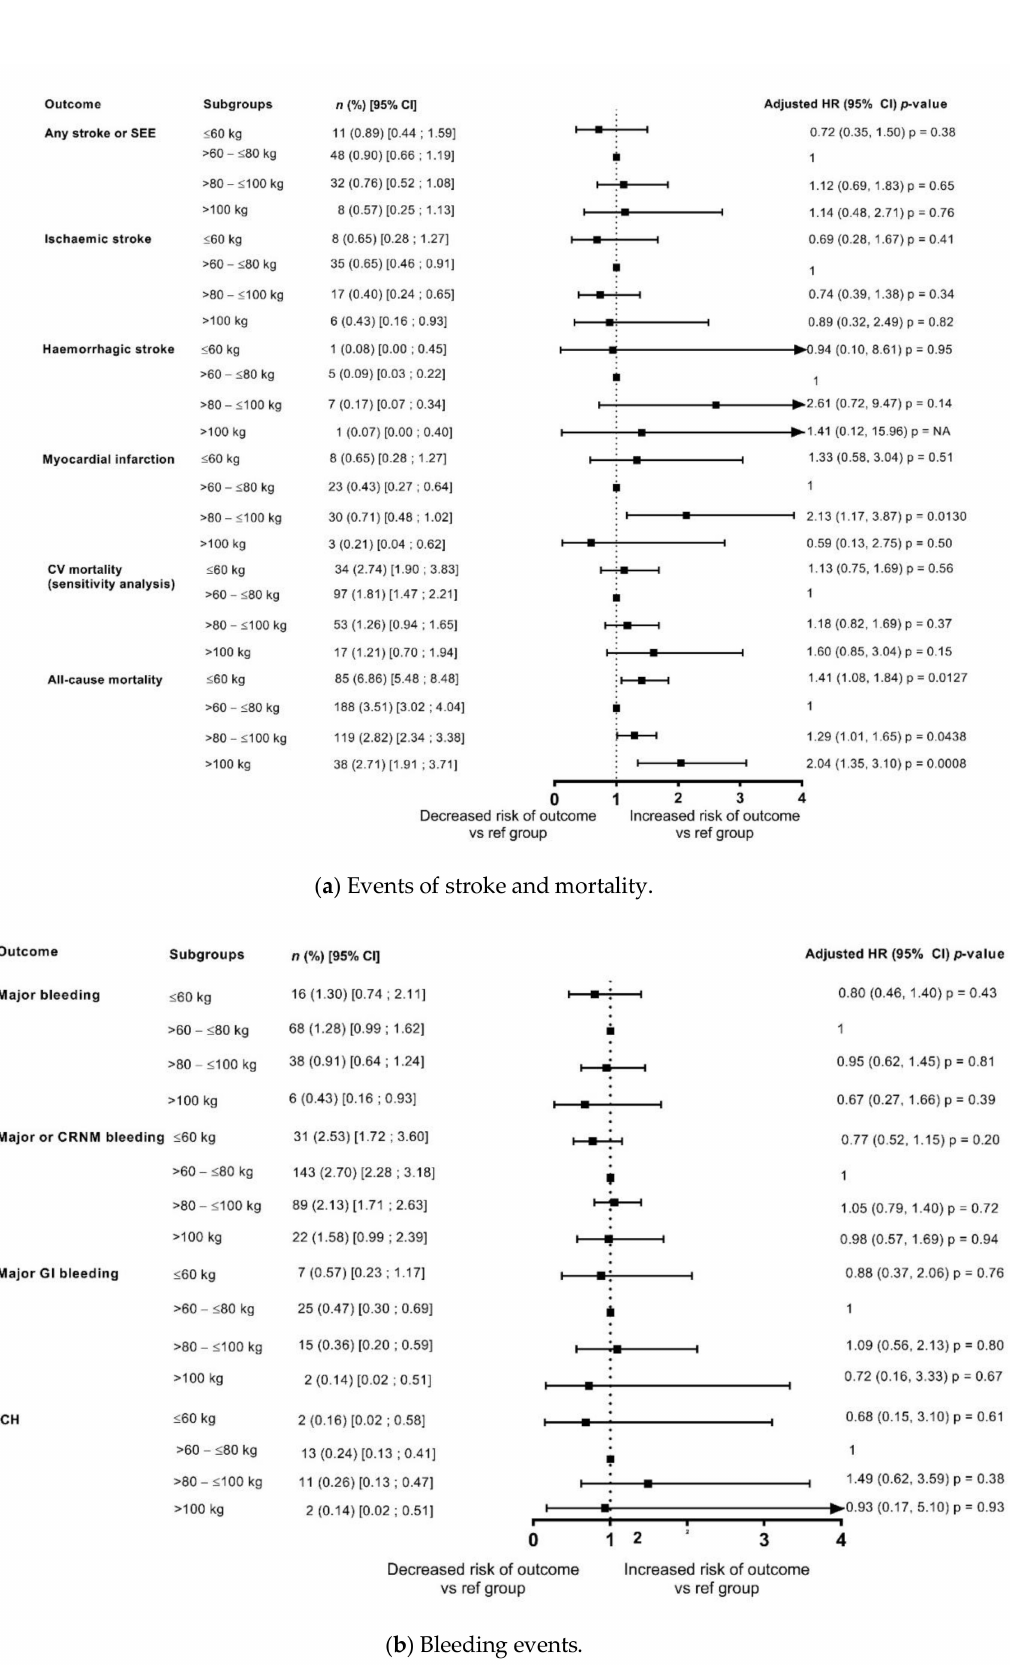
Figure 3. Outcomes at 1 year categorised by body weight (adjusted for eGFR and CHA 2 DS 2 -VASc score) compared with reference weight group (>60– ≤ 80 kg). ( a ) Events of stroke and mortality; ( b ) Bleeding events. CRNM, clinically relevant non-major bleeding; GI, gastrointestinal; ICH, intracranial